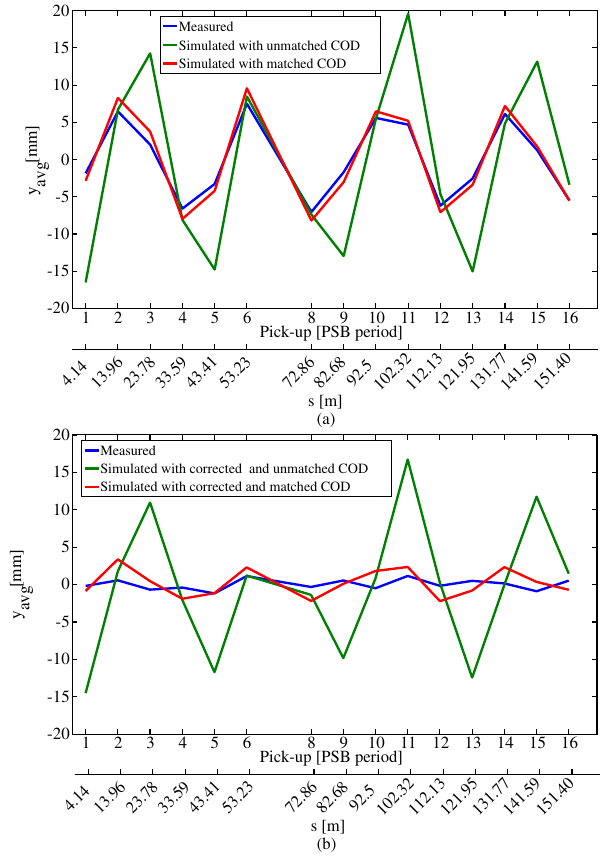
FIG. 3. The COD without (a) and with (b) measured COD matching for the lowest ( Q y ¼ 4 . 09 ) vertical working